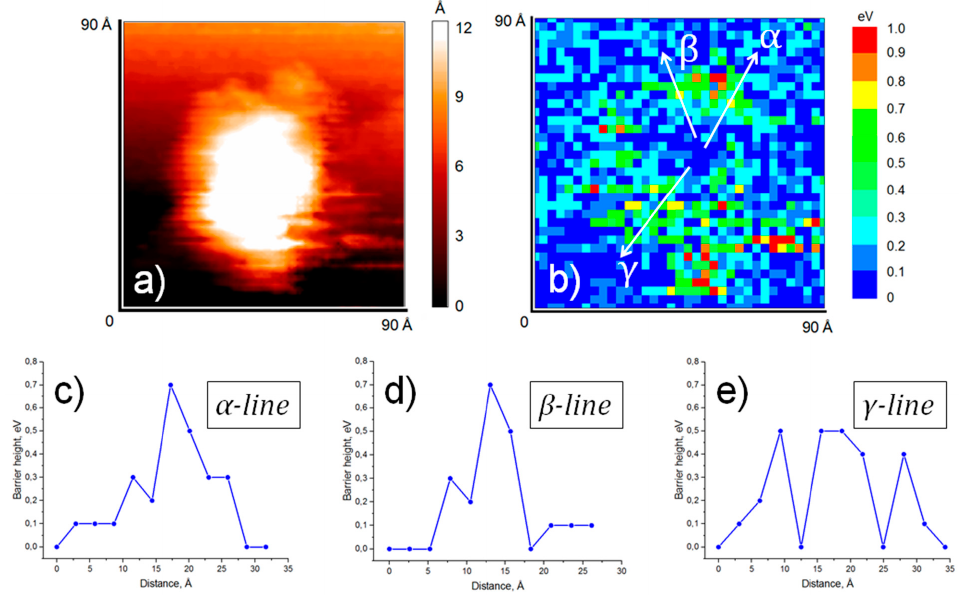
Figure 6. Single HOPG-supported gold nanoparticle after exposure to H 2 (200 L): ( a ) topography image, ( b ) map of the barrier height with marked radial sections, ( c–e ) energy diagrams for barrier height along the selected radial sections α , β and γ .